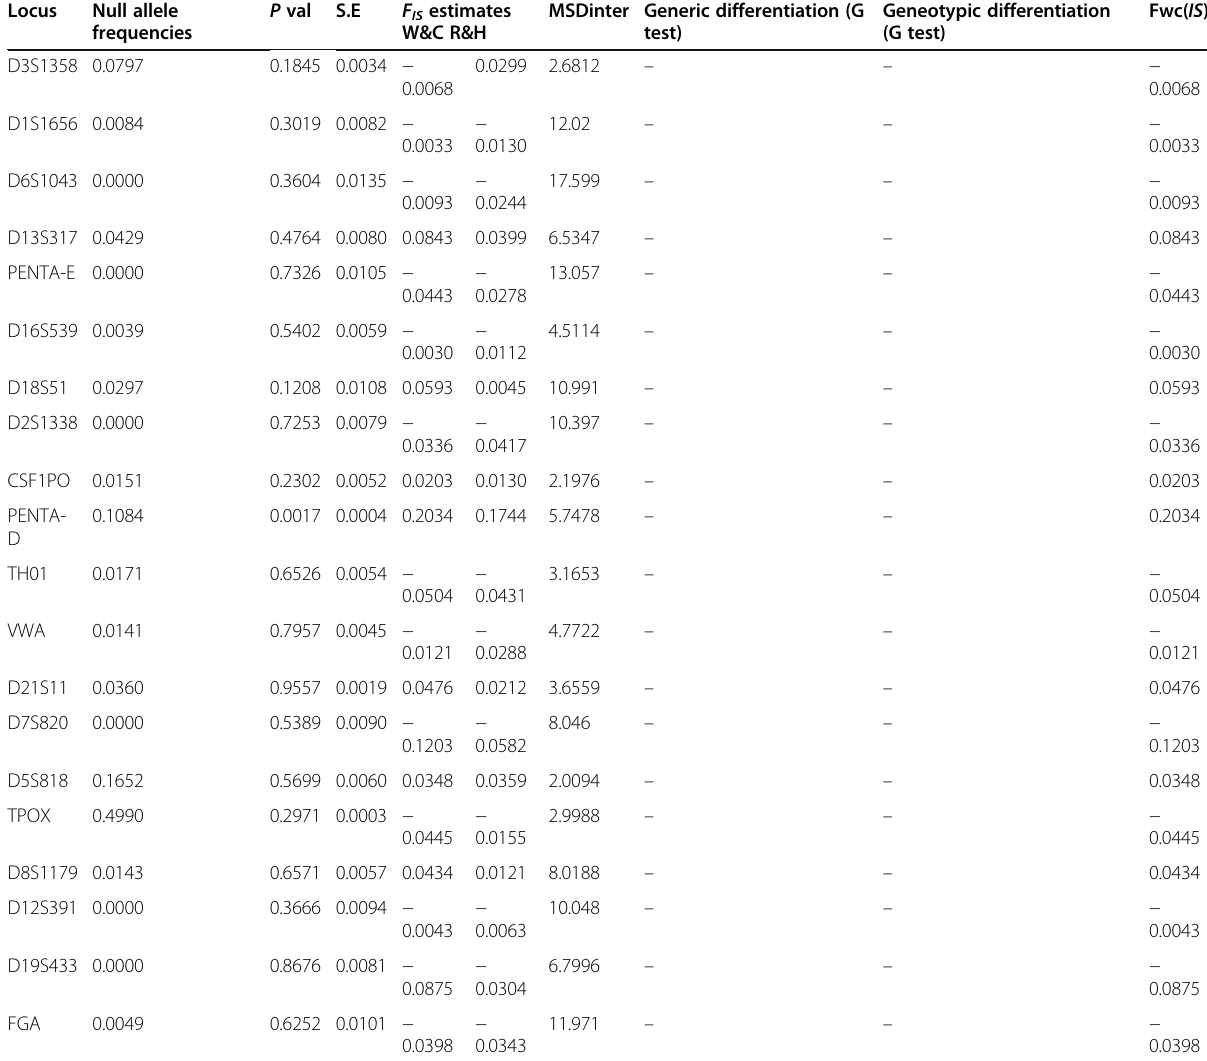
Table 4 Genepop output reporting the Hardy – Weinberg tests, global Hardy – Weinberg tests [score ( U ) test], mean squared allele size difference, tests and tables for linkage disequilibrium, population differentiation, Fis, and other correlation Locus Null allele P val frequencies